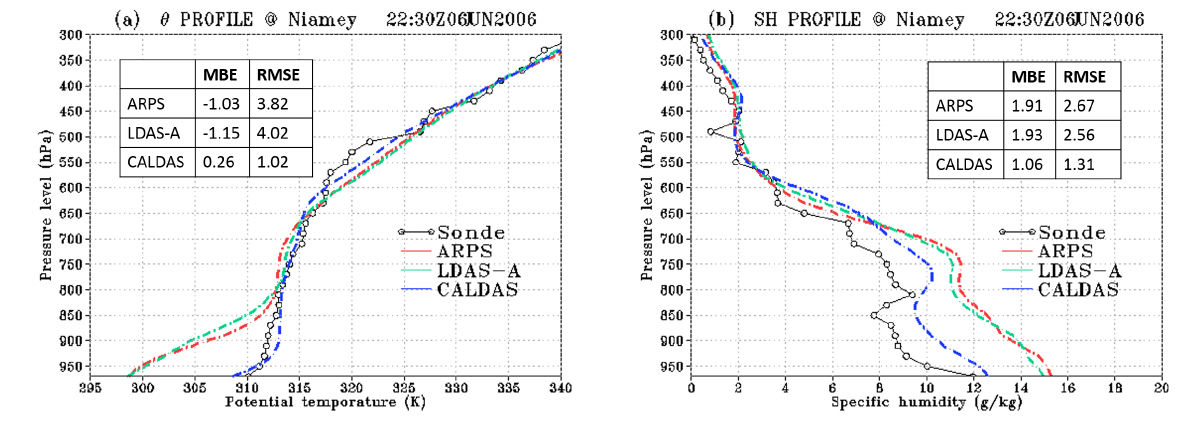
Figure 7. Same as Figure 6 but for 2230 UTC on 6 June 2006; ( a ) potential temperature (K) and ( b ) specific humidity